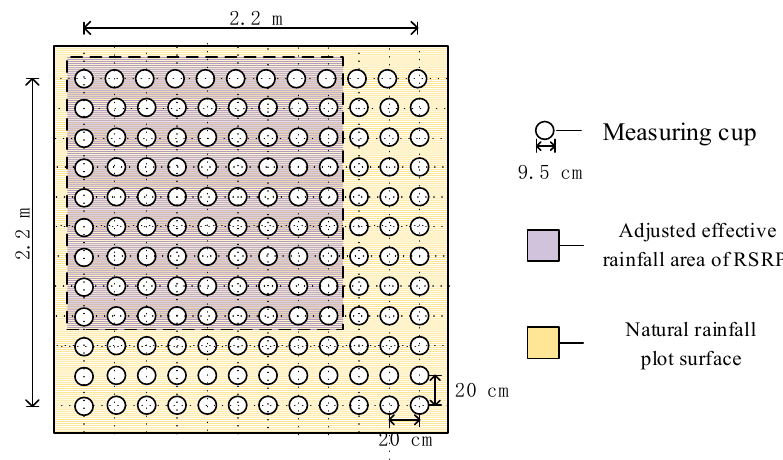
Figure 3. Schematic of the spatial uniformity experiments during naturally occurring rainfall events and the adjusted effective rainfall area (AREA) of RSRP. One-hundred forty-four measuring cups were used in the present study, and they were evenly distributed over an area of 2.2 m × 2.2 m. Sixteen test areas of 1.6 m × 1.6 m could be selected to have a statistic within the 2.2 m × 2.2 m area through moving the adjusted effective rainfall area (AERA) dashed square horizontally and vertically.